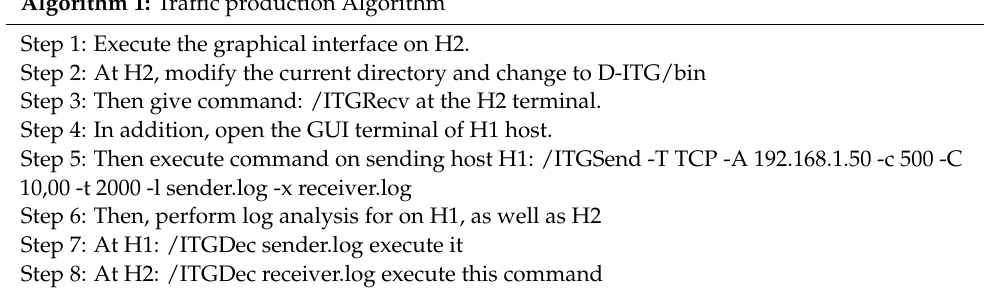
Figure 10. Comparison of the packet loss ratio for the proposed approach with (Zheng 2017) [25] as well as (Cha, 2017) [26]. Algorithm 1: Traffic production